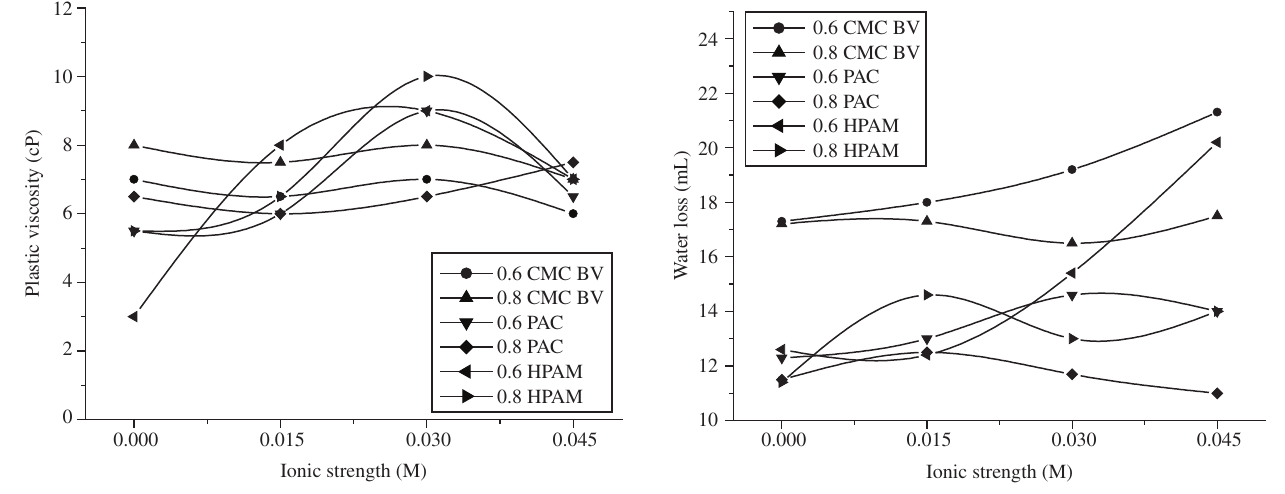
Figure 3. Influence of ionic strength on the water loss of bentonite suspen- sions treated with polymer.